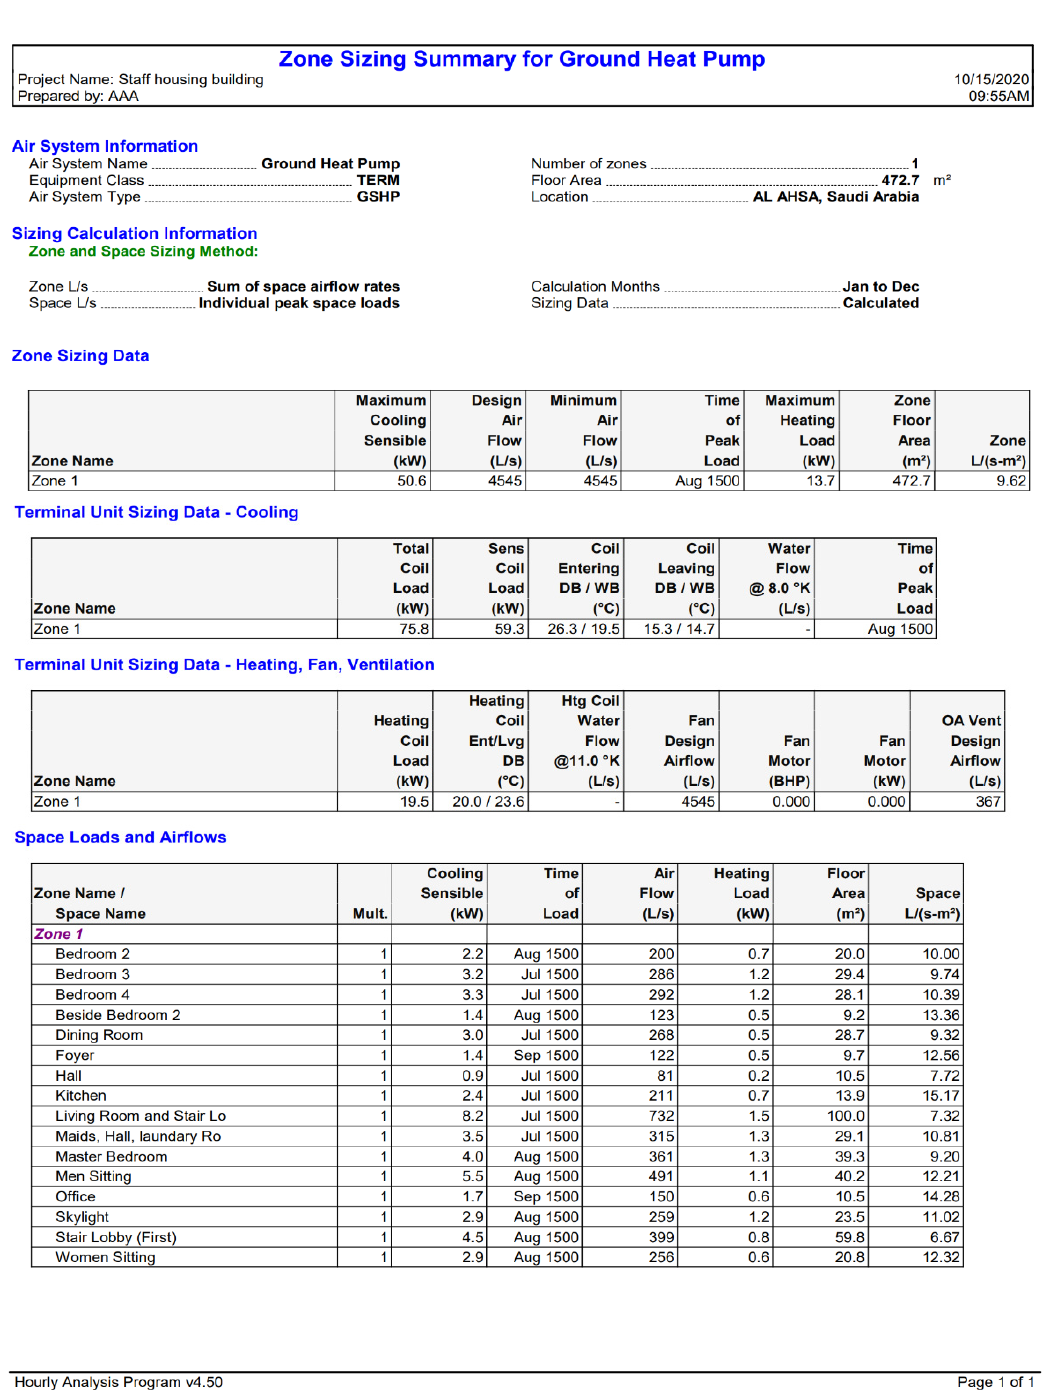
Figure A1. Design with HAP software for zone sizing summary for ground heat pump.